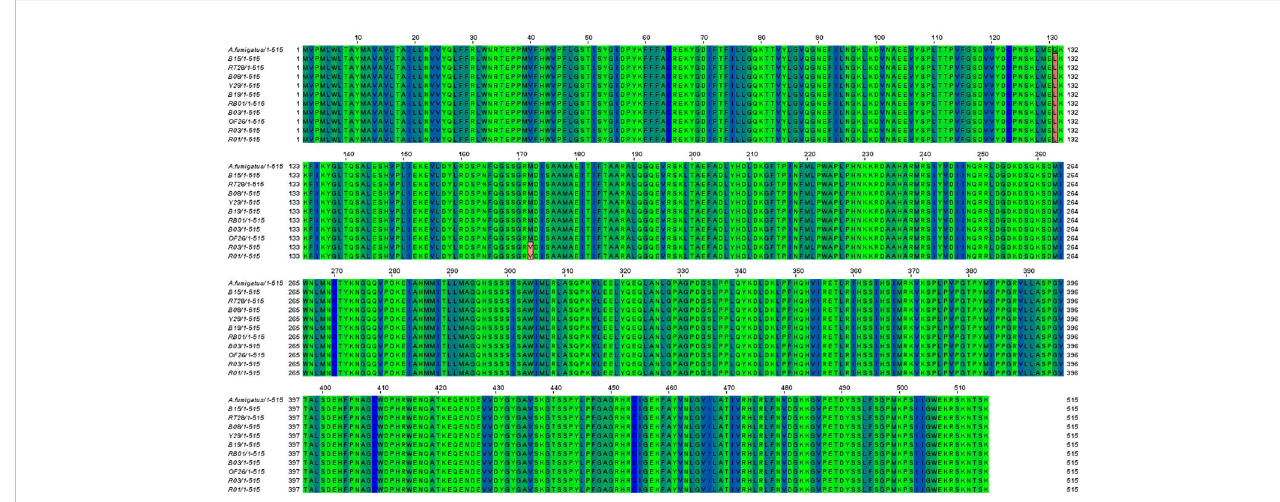
FIGURE 3 Sequence alignment of Cyp51A proteins from susceptible A. fumigatus (accession no. AF338659) and azole resistant isolates (B08, Y29, B19, B03, B15, OF26, R01, RT28, R03 and RB01). Identical residues were marked in blue and green shade whereas amino acid substitutions found in the Cyp51A sequence of the ARAF isolates were highlighted in red